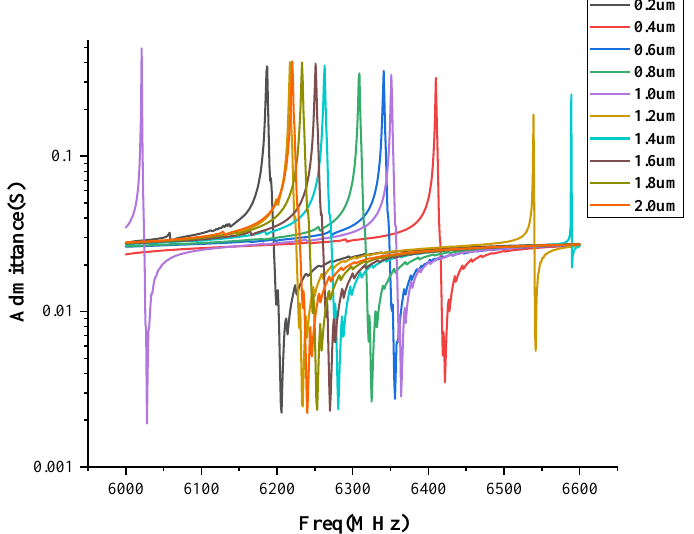
Figure 6. Absolute admittance of the polymer FBAR against the different polyimide thicknesses.